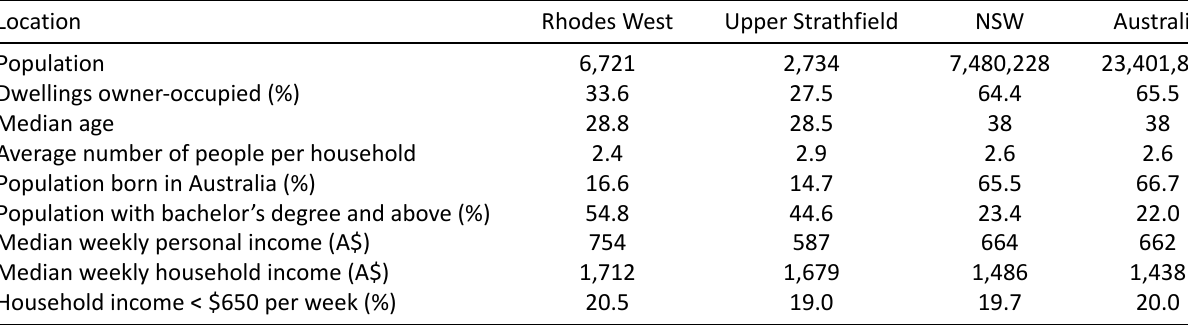
Table 1. Case study key